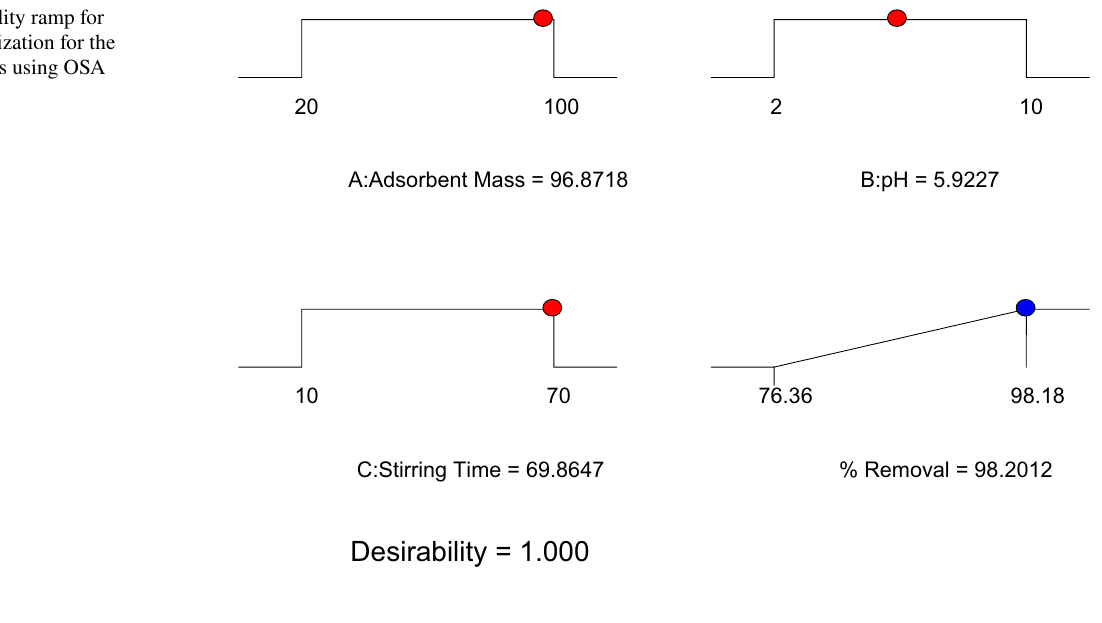
Fig. 19 Desirability ramp for numerical optimization for the selected variables using